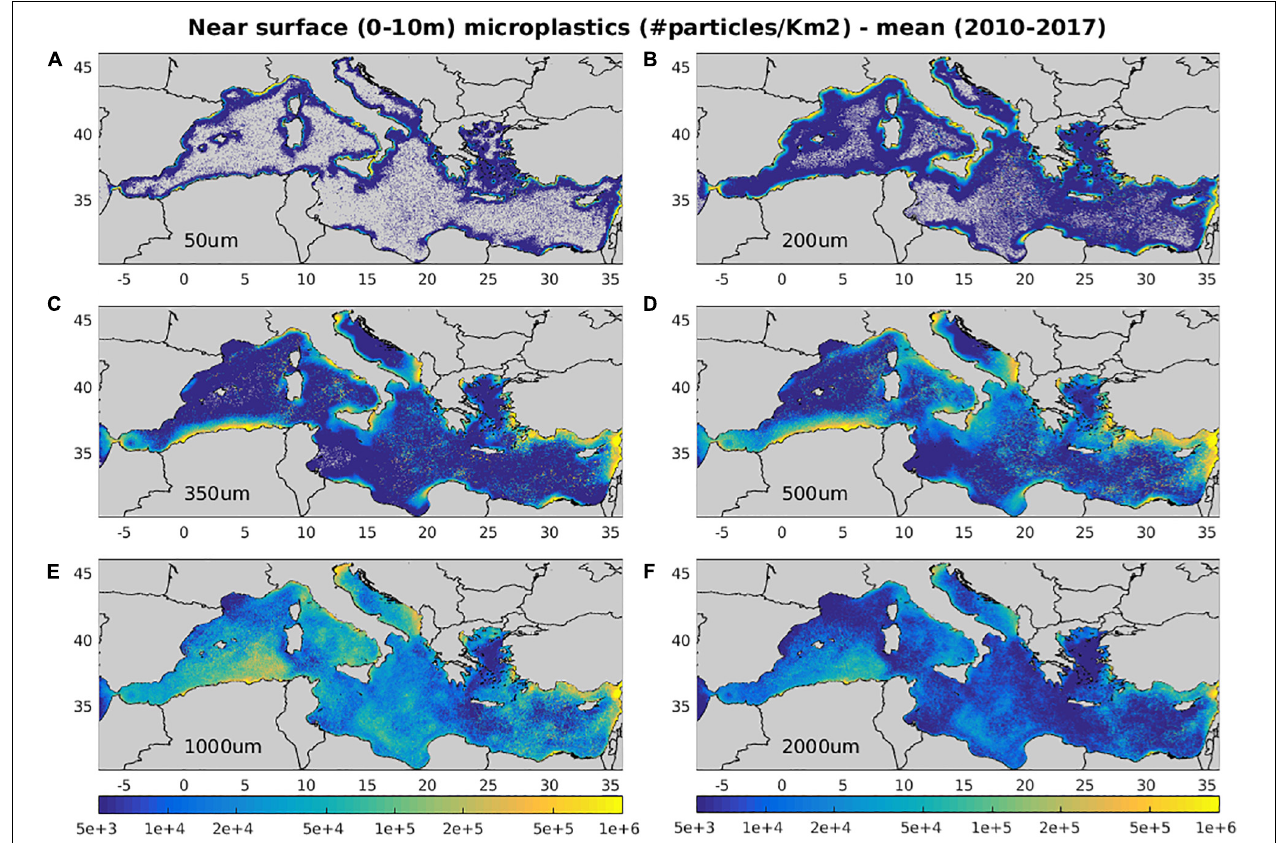
FIGURE 5 | Mean (2010–2017) model simulated near surface (0–10 m) (A) 50 µ m, (B) 200 µ m, (C) 350 µ m, (D) 500 µ m, (E) 1,000 µ m, (F) 2,000 µ m microplastics concentration (#/Km 2 ).